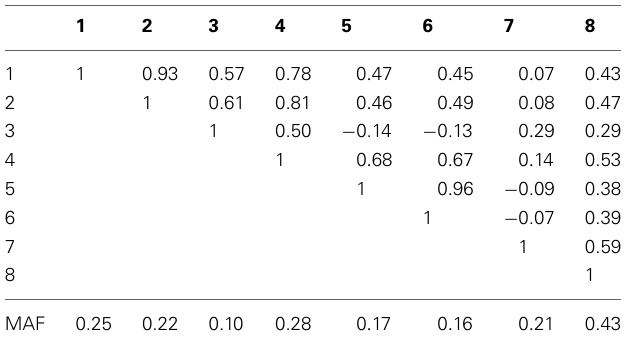
Table 2B | Estimated type-I errors (for OR = 1.00) and power ( OR =